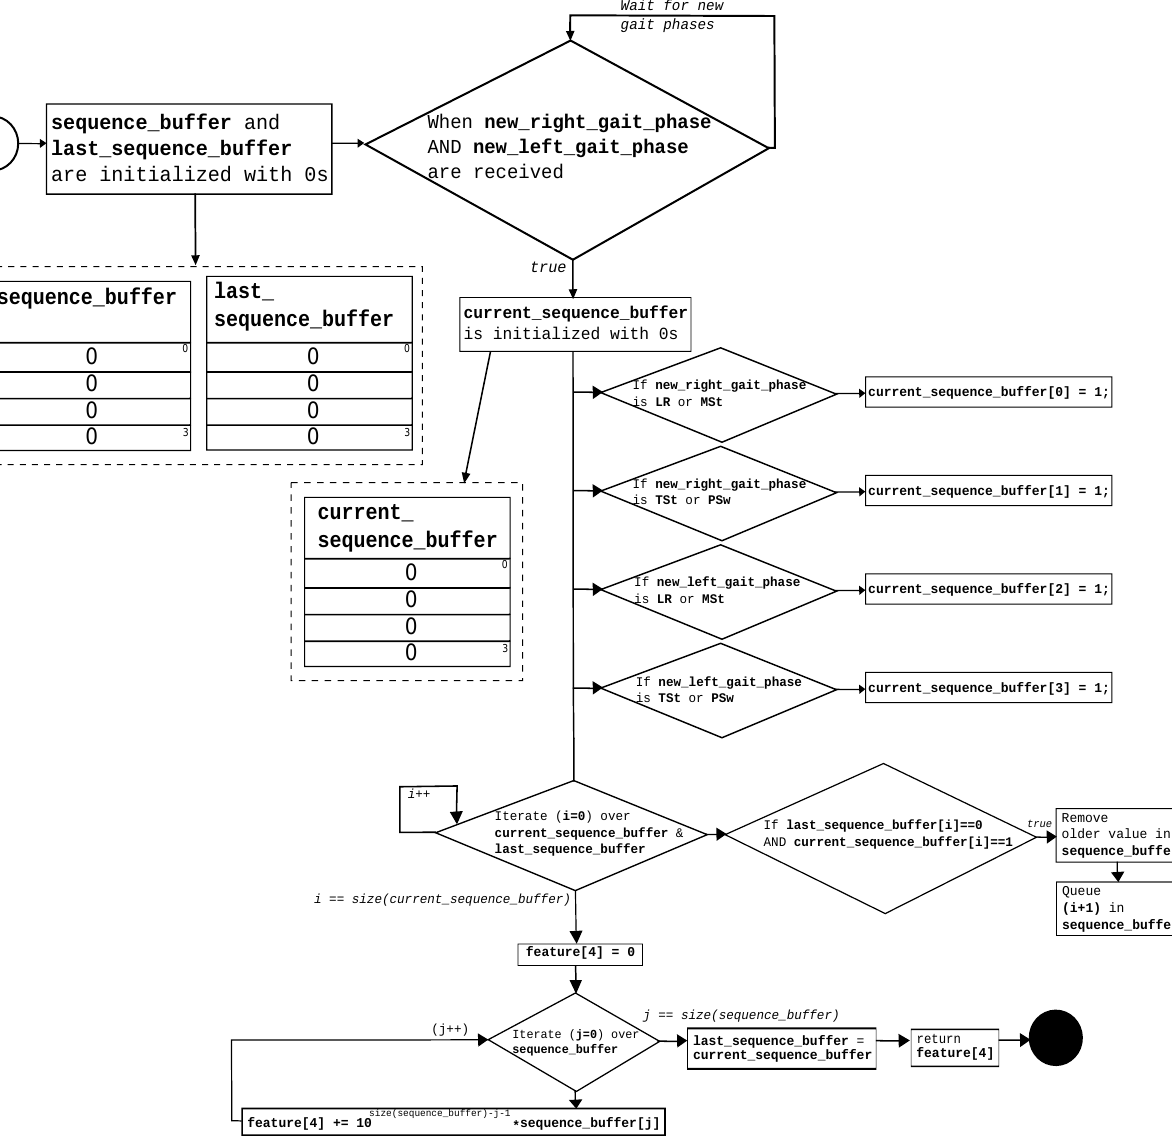
Figure 7. Feature 4: Computing the gait phase